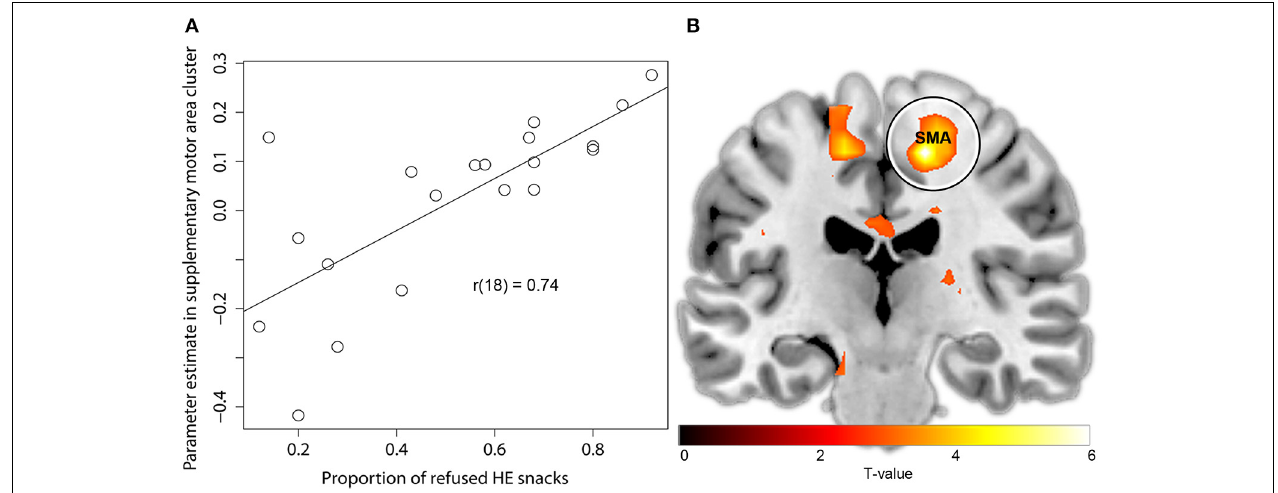
FIGURE 4 | Activation in the right SMA during the HE choice periods covaries with self-regulatory success. (A) Plot showing correlation between parameter estimate HE vs. baseline in right SMA cluster and the